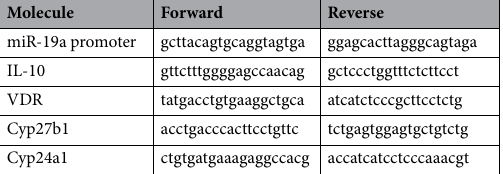
Table 2. Primers used in the